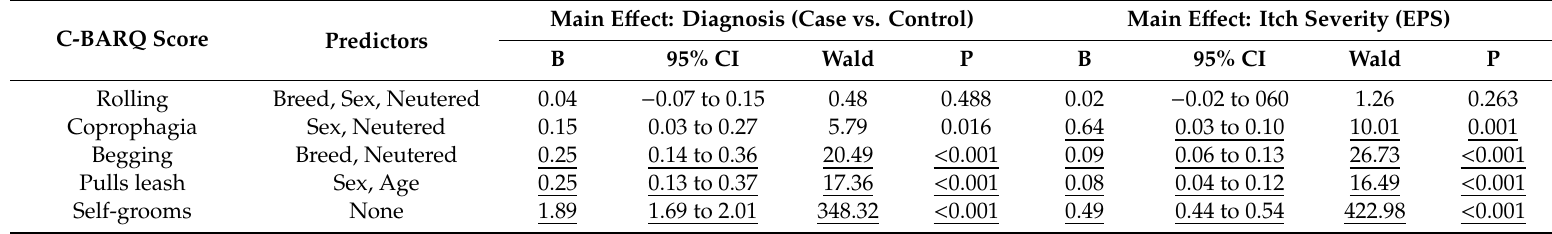
Table 3. Right skewed integer data analysed with a Poisson regression model. Statistics describe models with diagnosis (case) and scores on the Edinburgh Pruritus Scale (EPS) as the main e ff ect. Items underlined are considered statistically significant to a false discovery rate ( Q -value) of less than 5% ( < 0.05). Predictors remaining in the models were statistically significant to p < 0.05. B, the coe ffi cient for the main e ff ect; 95% CI, 95% confidence interval for B; Wald, chi-square value associated with B; P, p -value for